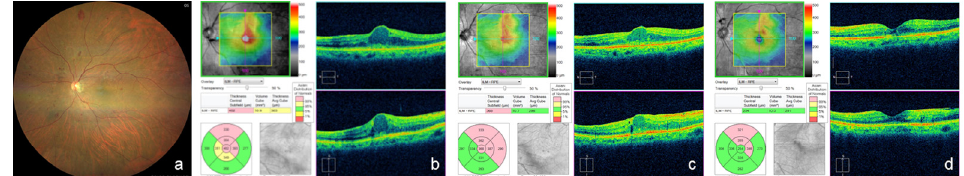
Figure 4. A switch case (case 14) with good response to the intravitreal faricimab injection. ( a ) A color fundus photograph at baseline; ( b – d ) optical coherence tomography images. Macular edema observed at baseline ( b ) slightly improved 1 month after the intravitreal faricimab injection ( c ) and almost disappeared at 4 months ( d ). No additional treatment was performed throughout the follow- up period.